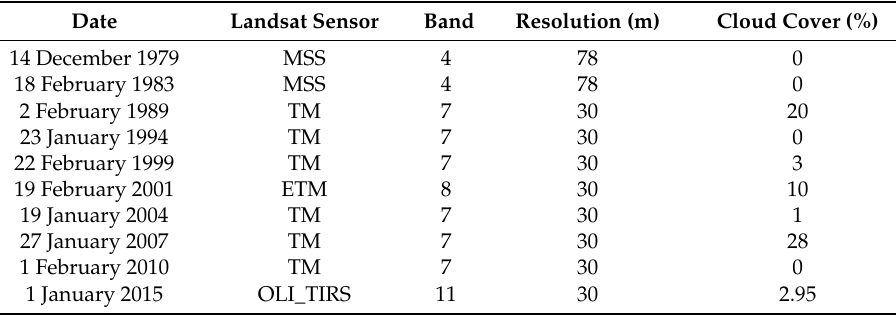
Table 1. Details of the selected Landsat satellite